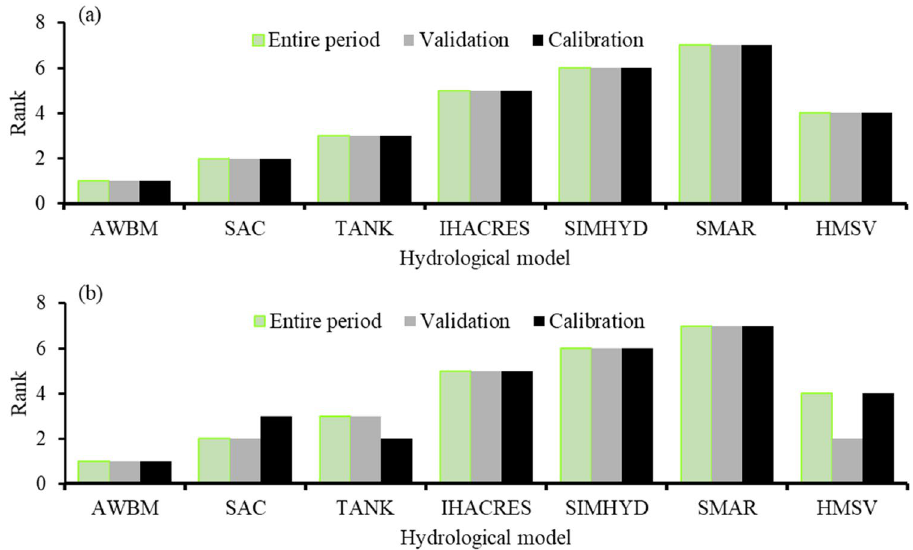
Fig. 4 Model performance in terms on ranking based on a Nash–Sutcliffe Efficiency (NSE), b Kling–Gupta efficiency (KGE). Ranks 1 and 7 denote best and worst performing model,